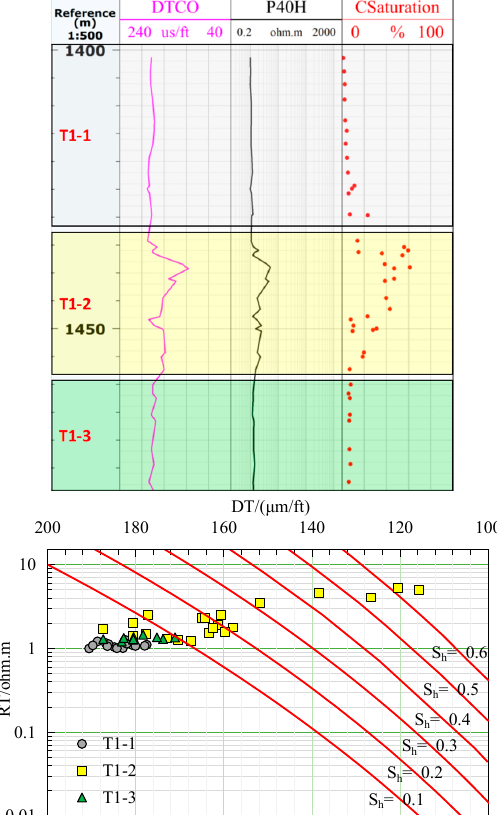
Figure 14. Well T1’s logging curves and quick recognition results from the resistivity–acoustic time difference cross chart of the key layer.